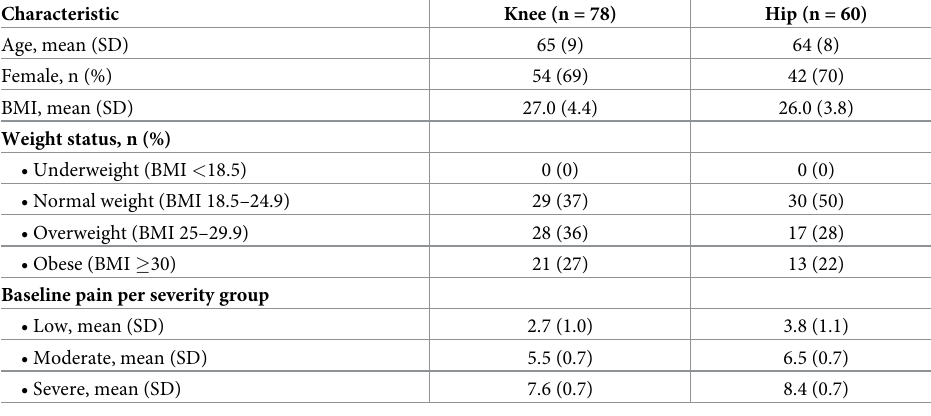
Table 2. Descriptive data for knee and hip OA in the 48-week sub-sample (n = 138).